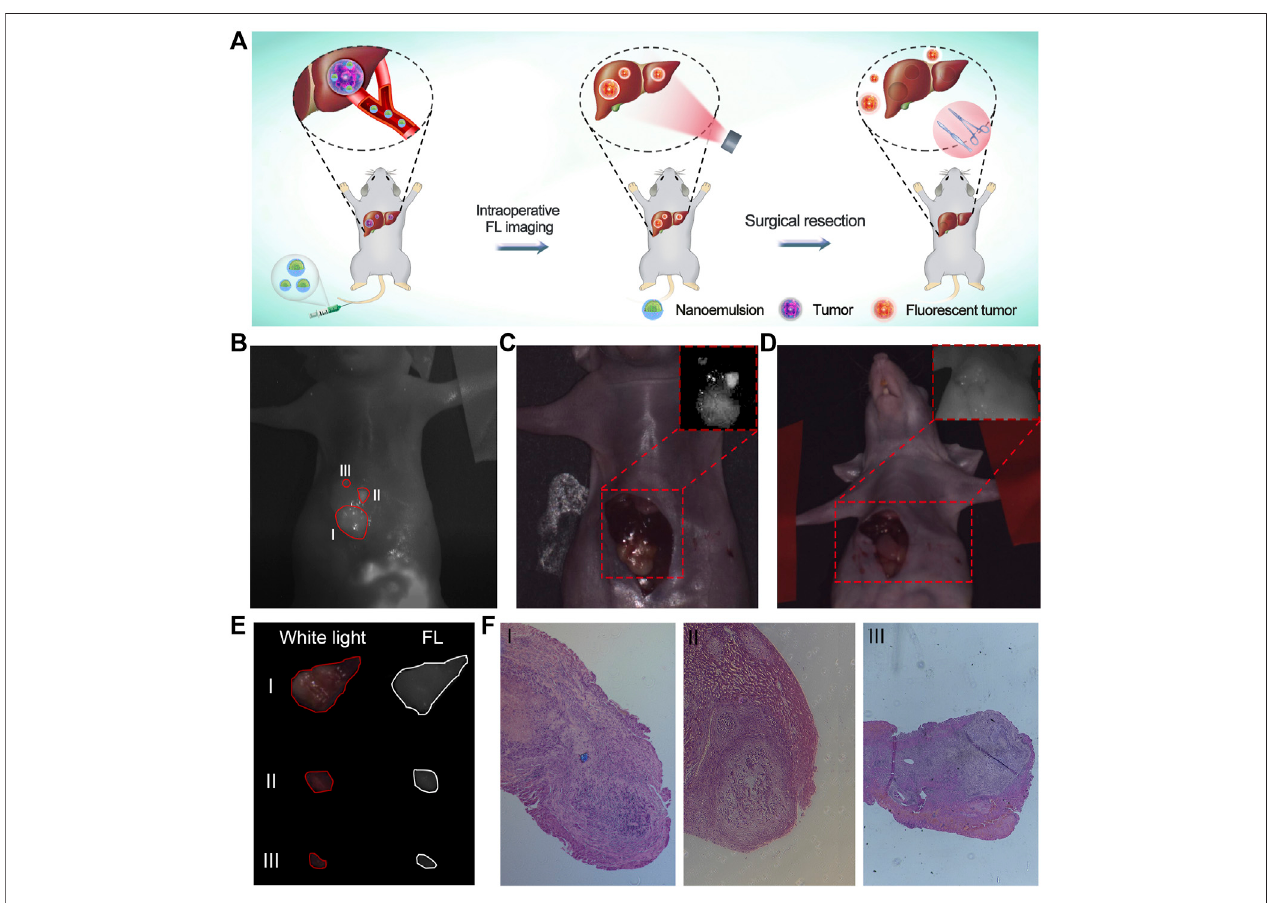
FIGURE 4 | (A) Schematic illustration of nanoemulsion for FL imaging-guided surgical resection of HCC. (B) Post-mortem FL images of orthotopic HCC-bearing miceundersurgicalnavigationimagingsystem. Image wastaken24 h after injection ofnanoemulsion. I,II,and III represent tumorswithdifferentsizes. (C) Pre-operative and (D) Post-operative white light images of orthotopic HCC-bearing mice. Insertions are the FL images of liver region under surgical navigation imaging system. (E) White light and FL images of resected tissues under the nanoemulsion-mediated FL guidance. (F) Histological analysis of tumor specimens from the resected